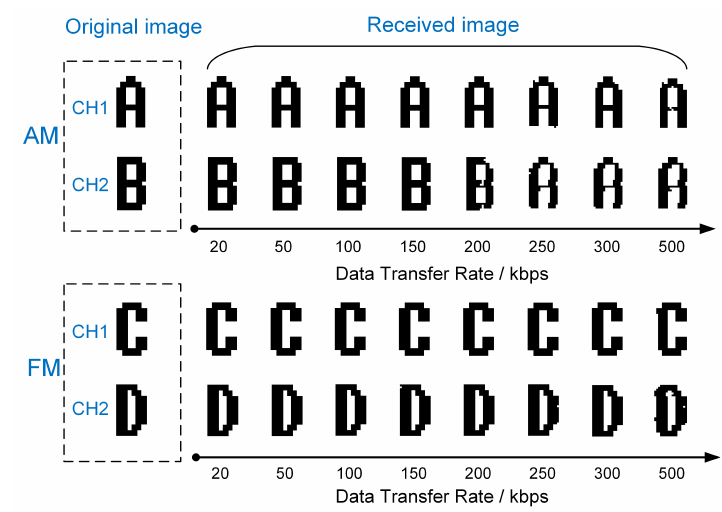
Figure 5. Test results of the proposed atomic FDM receiver for image data reception at different data transfer rates.